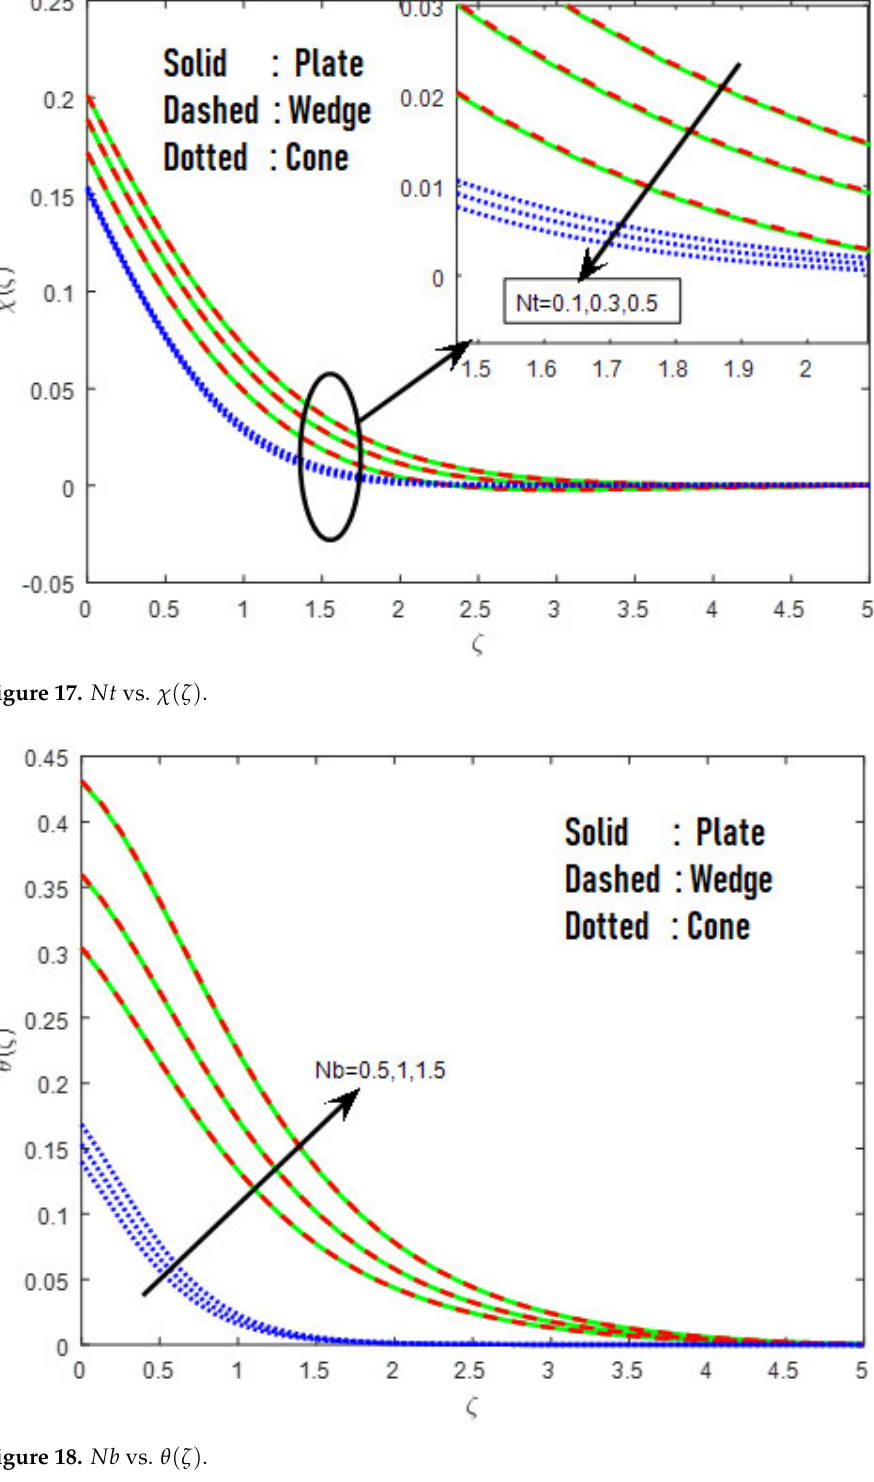
Figure 18. Nb vs.